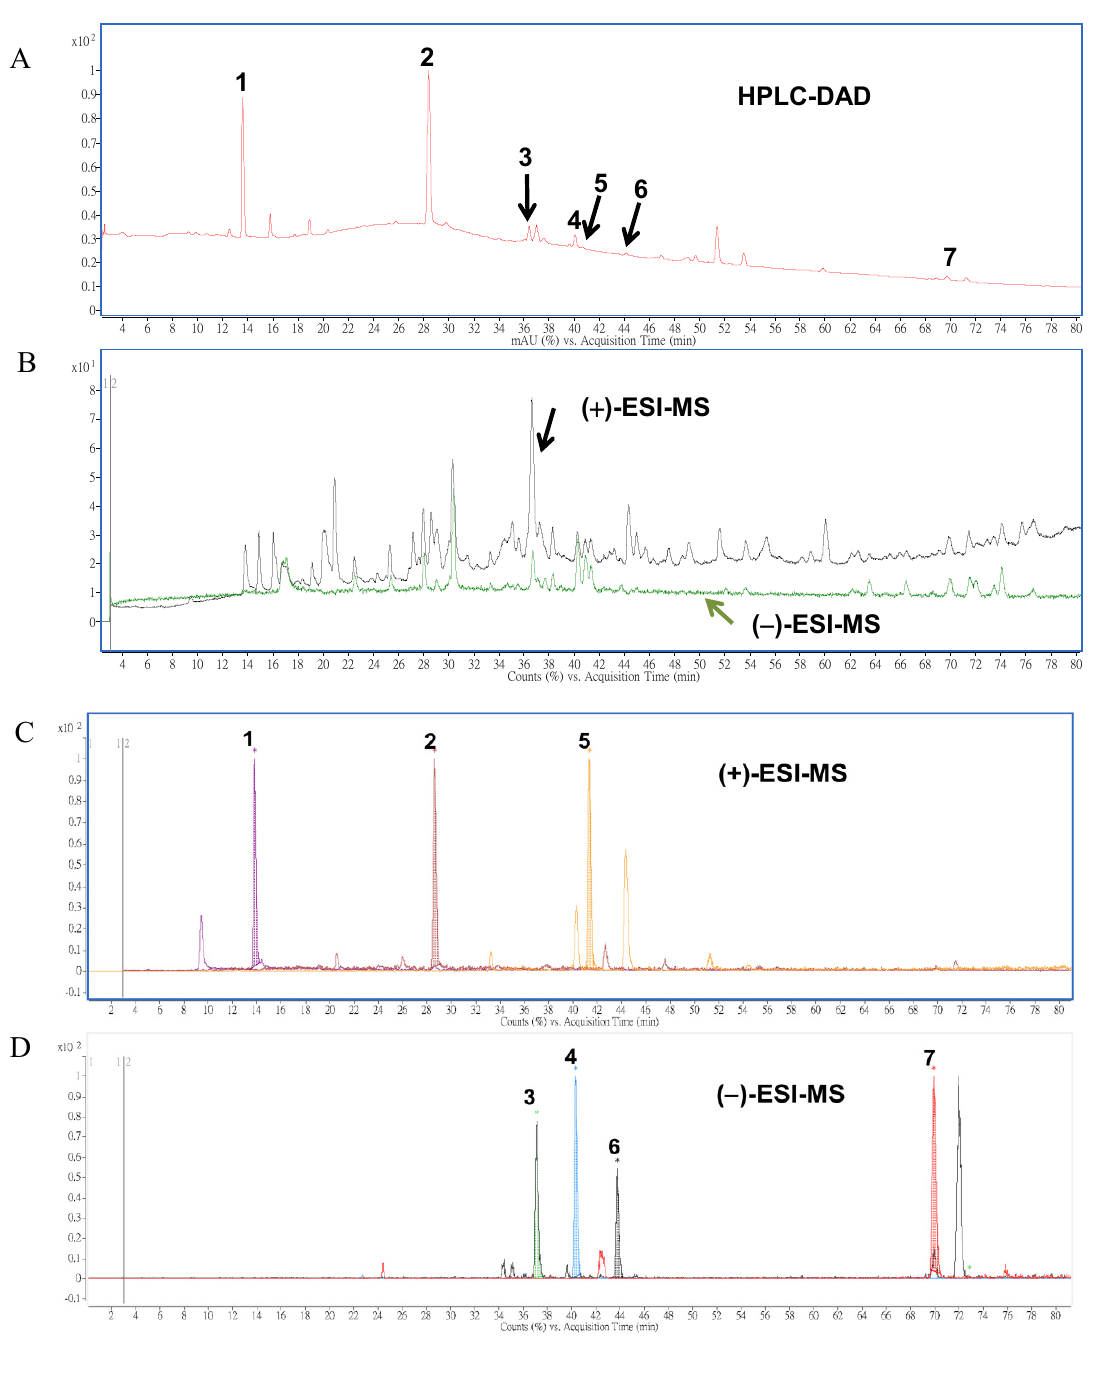
Figure 3. HPLC ( A ) and total ion chromatograms (TIC) of ESI-MS in positive (black line) and negative (green line) modes; ( B ) and the overlaid chromatograms of the molecular ions of benzenoid; ( C ) and triterpenoid compounds; ( D ) obtained by positive and negative ESI-MS analysis, respectively. Peak numbers and compound names correspond with Figure